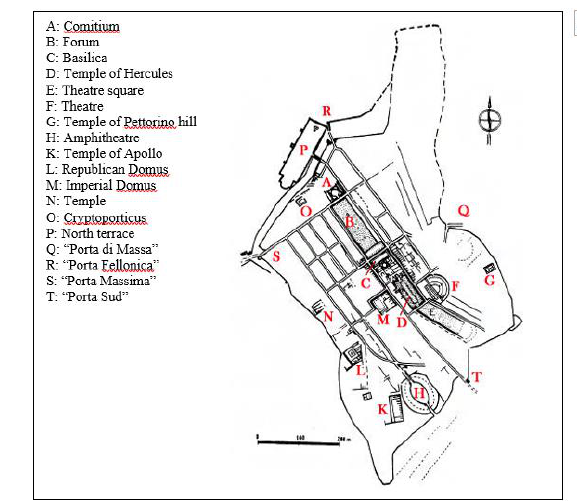
Figure 1. Alba Fucens Archaeological Site (Mertens,1969)